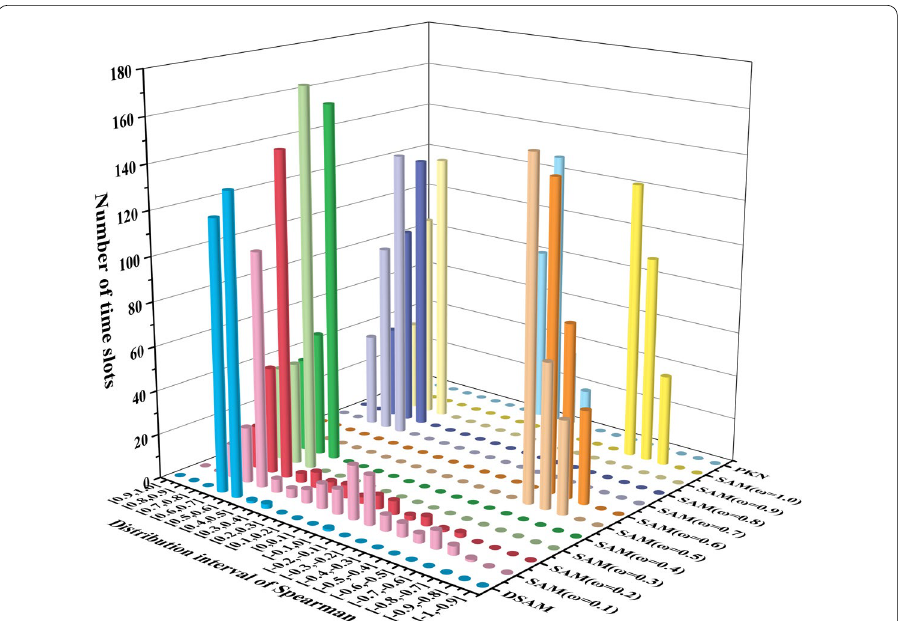
Fig. 5 Distribution of Spearman values calculated for the 259 time slots of